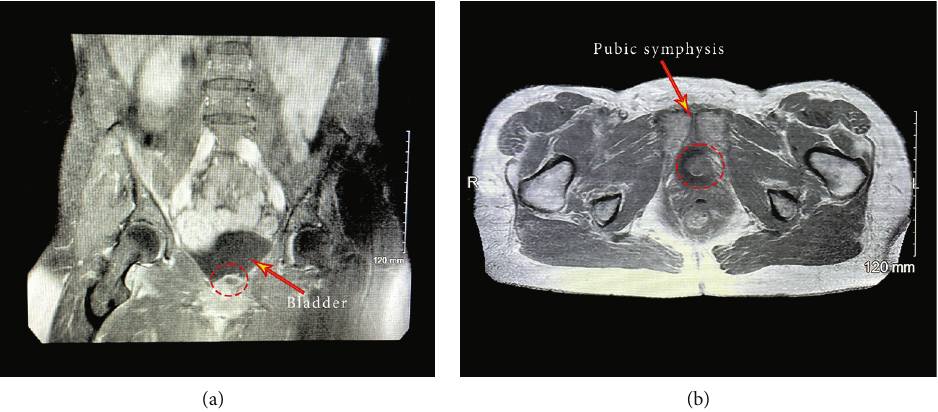
Figure 2: MRI of the pelvis demonstrating an unde fi ned structure in the posterior inferior left paramedian bladder wall protruding into the bladder (red circle). Image demonstrates decreased T1 with minimal increased T2 with questionable minimal enhancement of a thin rim with no internal enhancement.